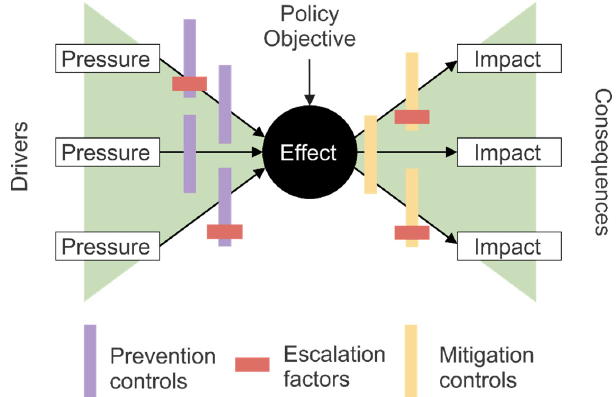
Figure 7. ISO 31010 Bowtie Analysis Tool to analyze the performance of the management system.